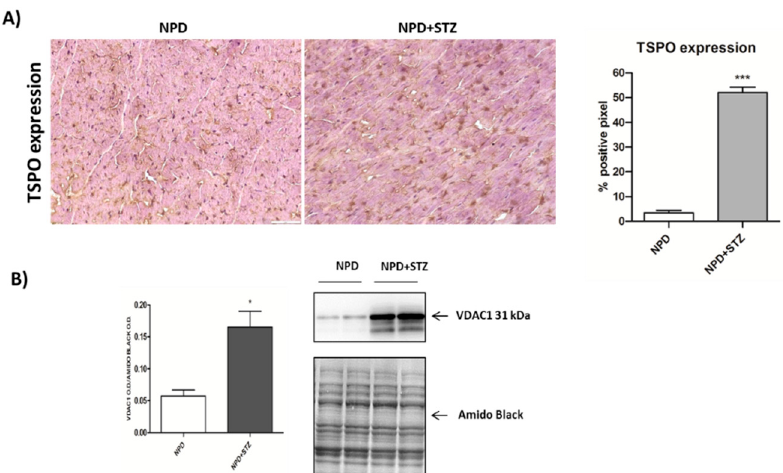
Figure 4. Effect of hyperglycaemia on translocator protein (TSPO) and voltage ‐ dependent anion ‐ selective channel 1 (VDAC1) expression in myocardial tissue. ( A ) On the left, representative images showing that, in the STZ group, an up ‐ regulation of TSPO expression was observed in comparison with the NPD group. On the right, quantification of TSPO expression related to immunohistochemistry analysis. ( B ) Densitometric analysis of VDAC1 expression assessed by Western blot assay showing the enhancement of protein level in mitochondrial fraction under hyperglycemia (on the right, representative images of Western blot) The data are presented as mean